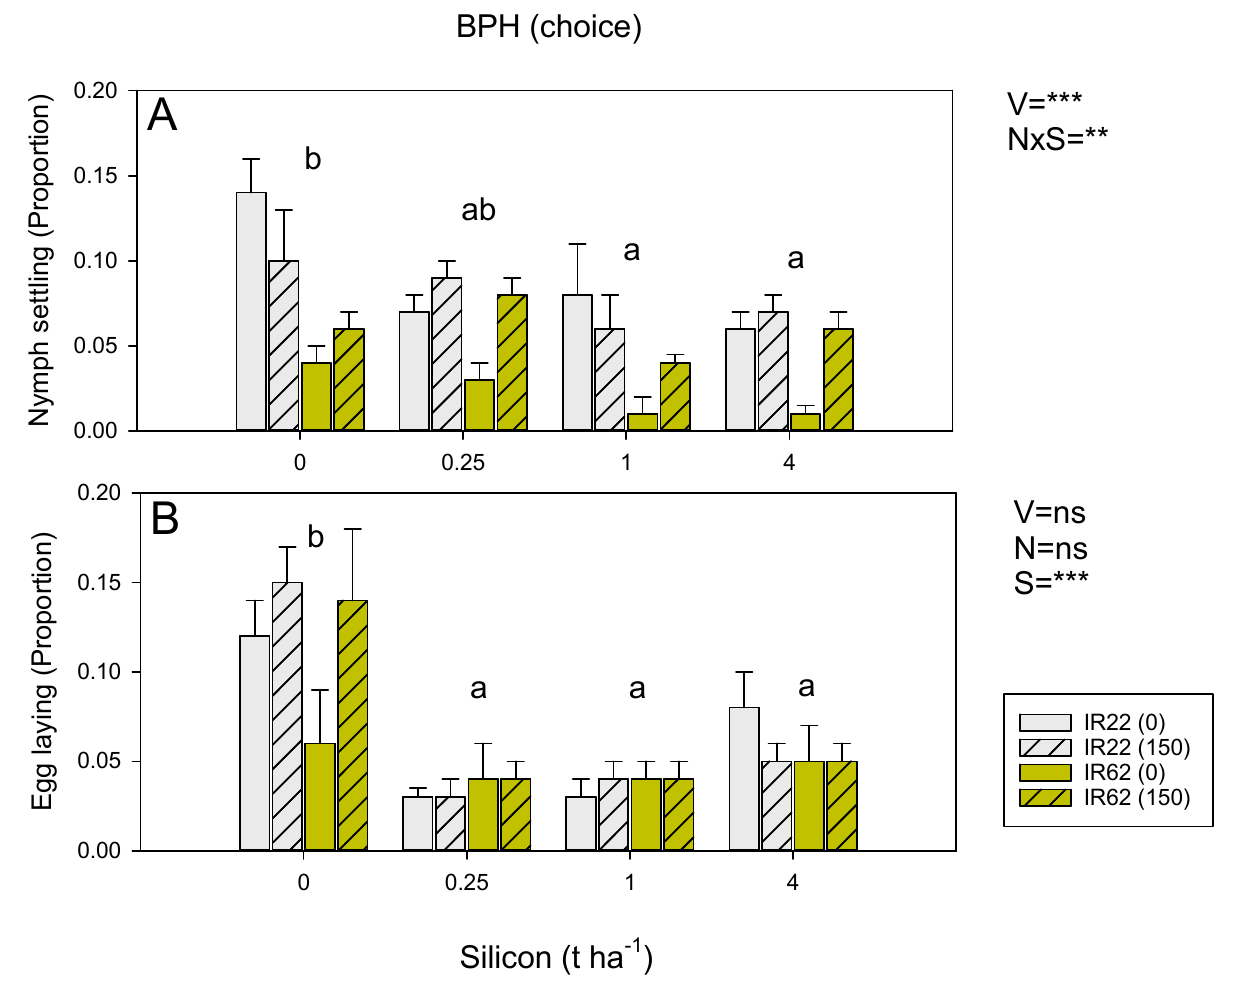
Figure 3. Effects of host resistance, soil nitrogen and soil silicon on ( A ) BPH nymph settling, and ( B ) BPH egg laying during choice experiments conducted in the Philippines. The experiments were conducted using IR22 (susceptible = gray bars) and IR62 (resistant = yellow bars) at 0-added (solid bars) and the equivalent of 150 Kg ha − 1 (hatched bars) added nitrogen. Soil was amended with 0, 0.25, 1 and 4 t ha − 1 equivalents of silicon. Standard errors are indicated (sample size = 6). Summary statistics for univariate general linear models are indicated as V = variety, N = nitrogen level, S = silicon, N × S = nitrogen × silicon interaction, ns = p > 0.05; ** = p ≤ 0.01, and *** = p ≤ 0.001; lowercase letters indicate homogenous silicon groups. See also Table S5.